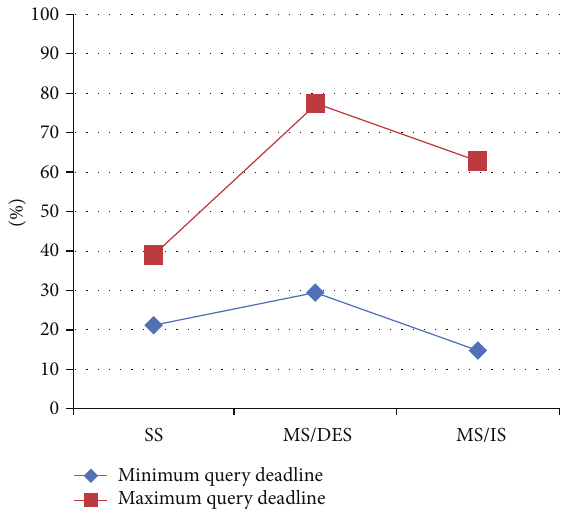
Figure 8: Results of Network Life Time performance metric for different battery